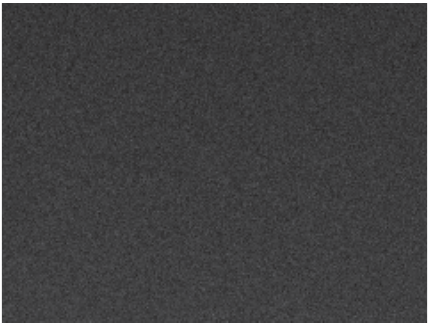
Figure 3: Frame 1 from the image sequence at wavelength 4 𝜇 m.